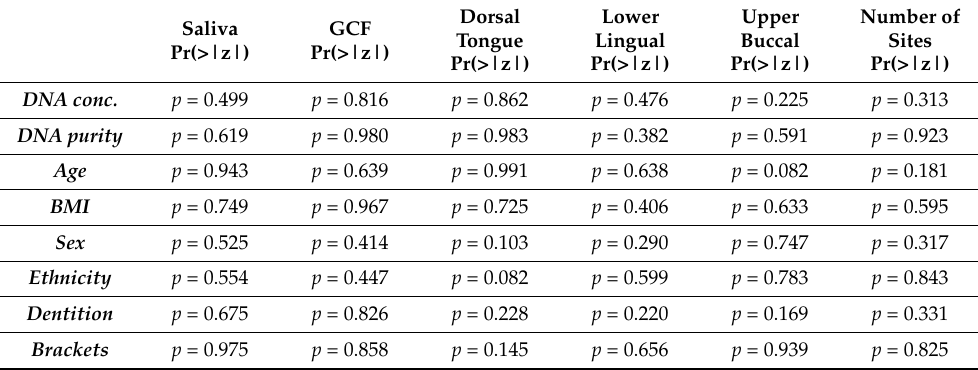
Table 2. Negative binomial regression analysis of study results.